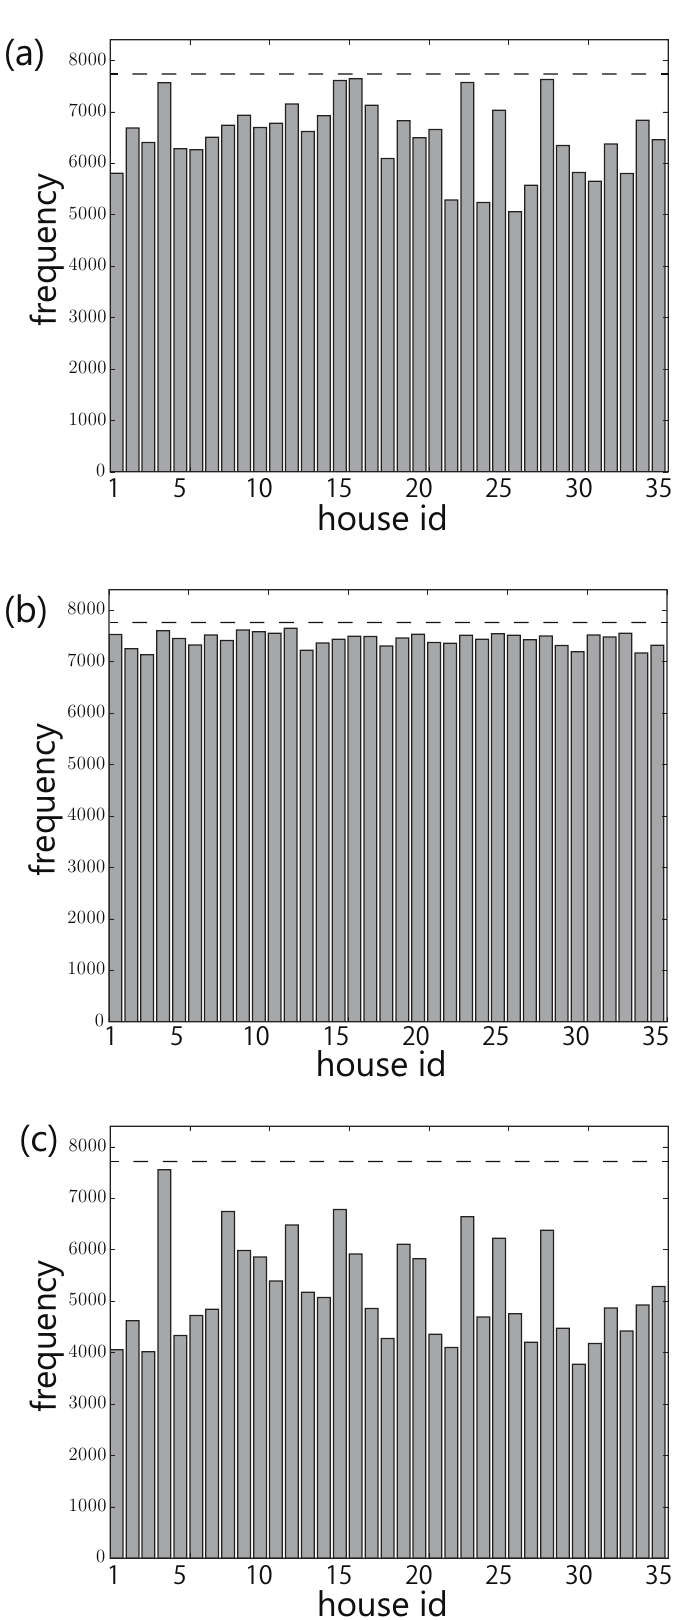
Figure 3. The results of normality test for ( a ) electricity consumption; ( b ) photovoltaics (PV) generation; and ( c ) net load. Y -axis shows the number of non-normal histograms. Dotted lines show the total number of histograms that were